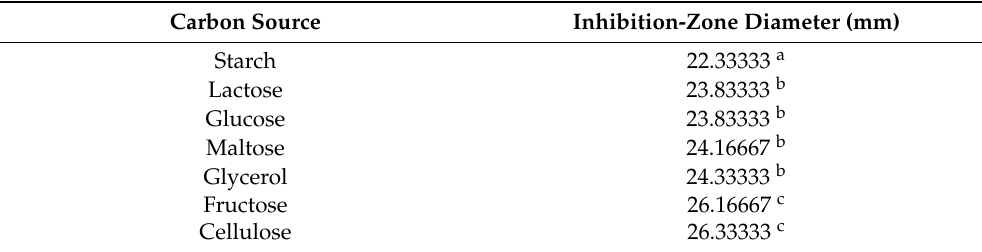
Table 3. Mean values of inhibition-zone diameters obtained by testing cultivation broth samples against aflatoxigenic isolates in the carbon source selection investigation step.